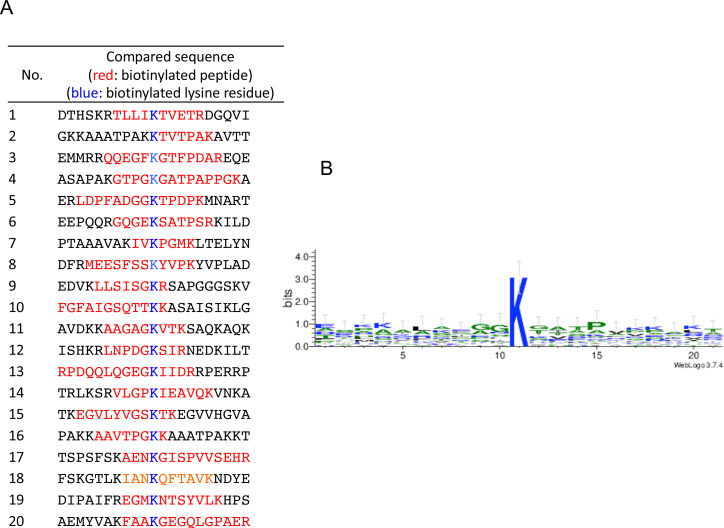
Biotinylation site characteristics.Twenty sequences around the biotinylation site were compared on the basis of the results of analysis by LC-MS/MS. The results were (A) listed, and (B) the sequence logo was generated using WebLogo (http://weblogo.berkeley.edu/).